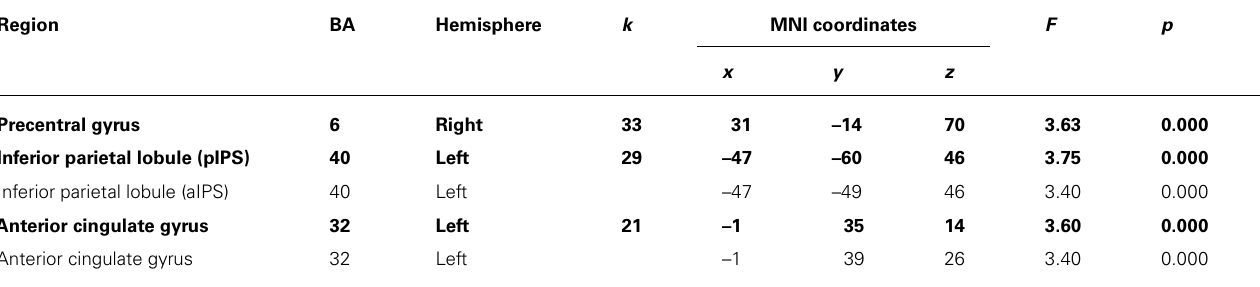
Table 1 | Brain regions showing interaction effects between type of movement (grasping, reaching) and stimulus dimension (small, large) across all 10Time Bins. Region BA Hemisphere